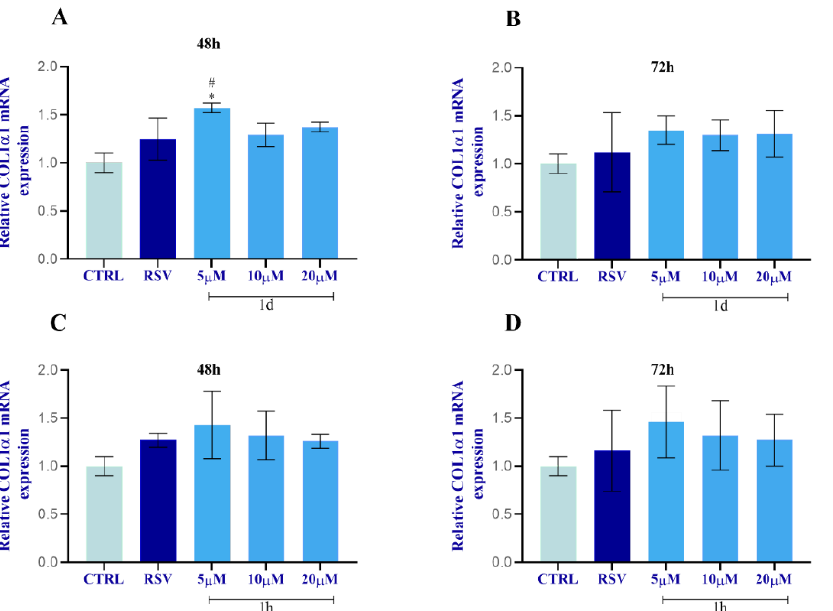
Figure 14. Effects of 1d ( A , B ) and 1h ( C , D ) on COL1 expression at 48 h and 72 h. The histograms represent normalized data for the housekeeping GAPDH. The values represent the average of three independent experiments with the relative SD (error bars). * Significance with respect to CTRL, * p < 0.05; # significance with respect to RSV, # p < 0.05.